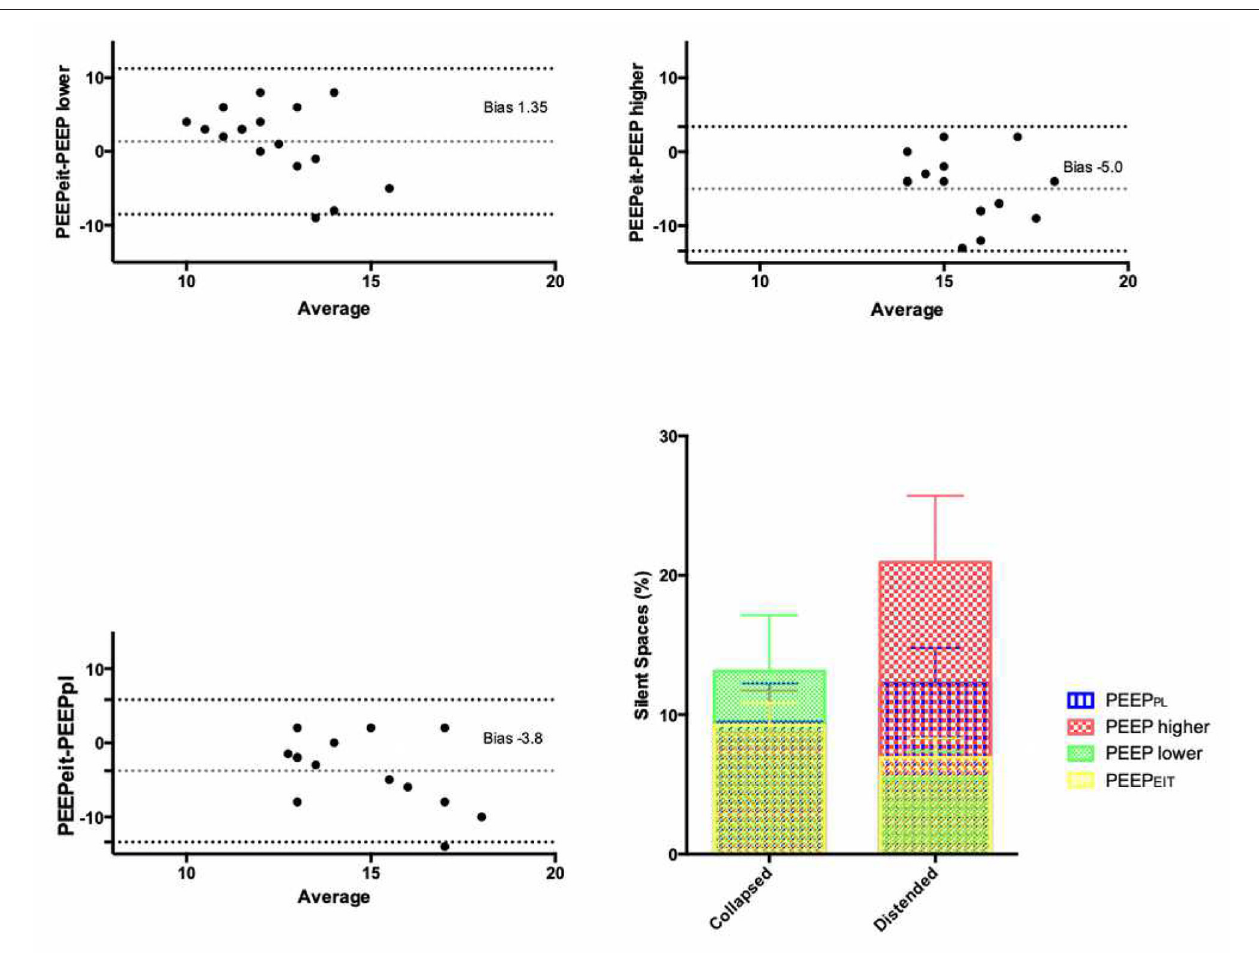
FIGURE 1 | Bland-Altman plots evaluating agreement between PEEP derived from EIT (PEEP EIT ) and positive end-expiratory pressure (PEEP) values derived from lower and higher PEEP/FiO 2 tables and P L /FiO 2 table. Dotted lines: bias and its 95% confidence interval. Lower right panel: percentages of collapsed and distended lung regions measured by electrical impedance tomography (EIT) under different PEEP settings. Percentage of collapse was lower with PEEP EIT than with lower